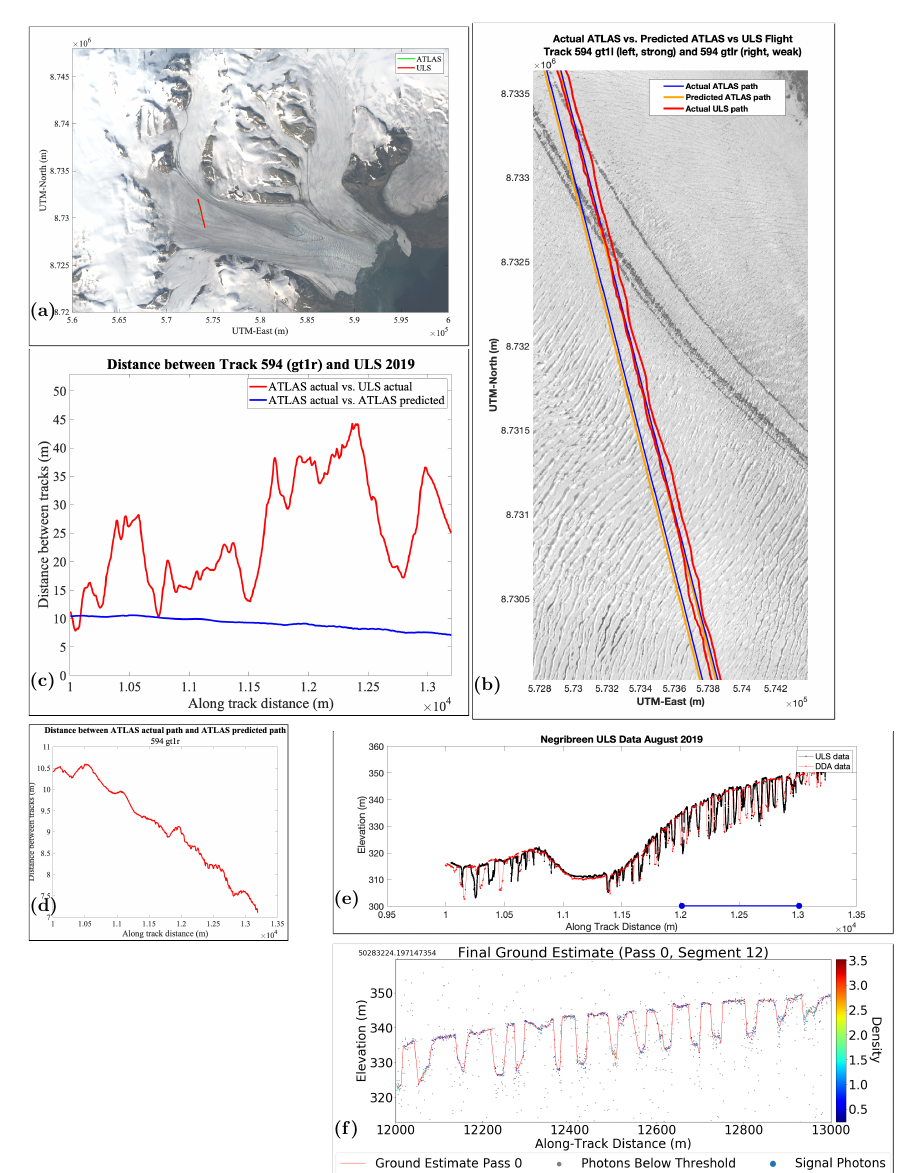
Figure 13. ICESat-2 ATLAS vs. ULS data. Track repeat accuracy and results. RGT 594, gt1r (weak), overpass 1. Negribreen validation campaign. Flight 2, 13 August 2019. ( a ) Location of DDA segments over Negribreen and closest ULS data (note the tracks are so close that the green line disappears under the red line). For segment numbering, see Figure 9 (ATLAS DDA segments). Background: lengths in ( a , c – e ) are the same, segments in ( b , f ) are subsets. ( b ) Track separation between our ULS flight path, the ATLAS predicted flight path, and the ATLAS actual flight path for granule: